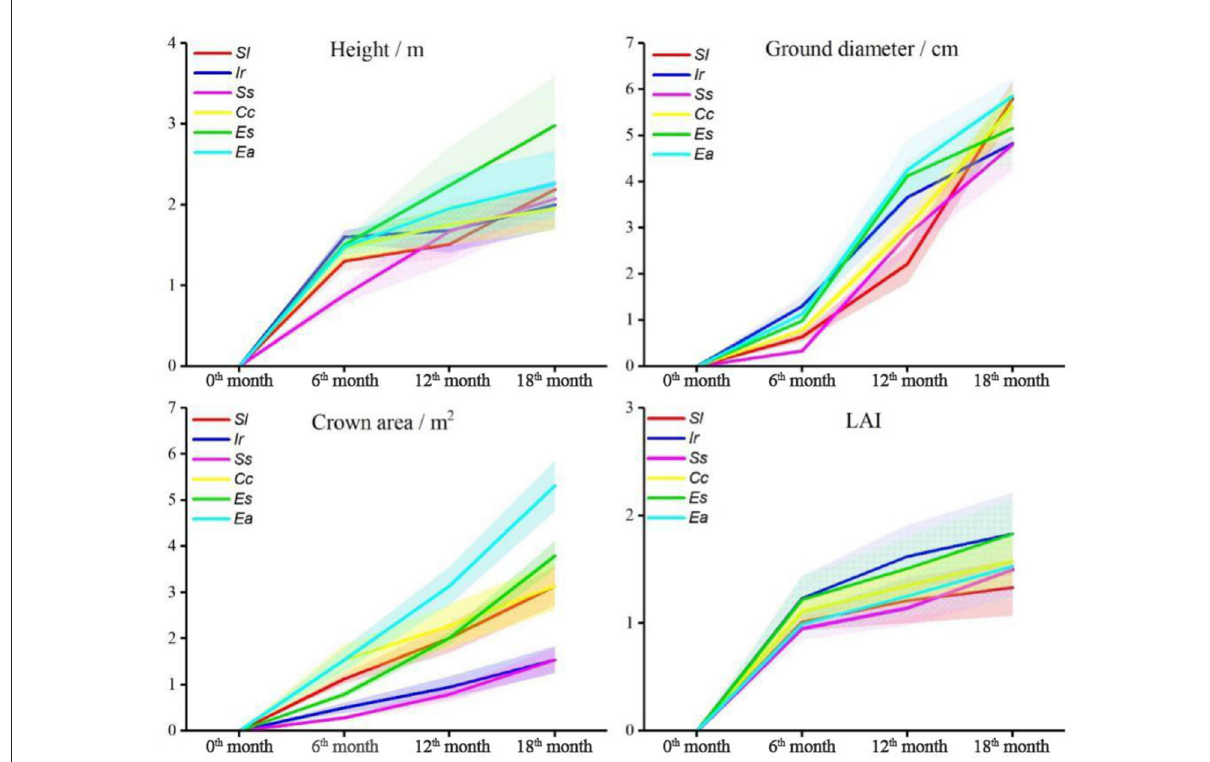
FIGURE3 Development of tree height (m), ground diameter (cm), crown area (m 2 ), and LAI of all the six tree species from the 0 to 18th month since plantation. The abbreviations of Sl , Ir , Ss , Cc , Es , and Ea were short for Sterculia lanceolata , Ilex rotunda , Schima superba , Cinnamomum camphora , Elaeocarpus sylvestris , and Elaeocarpus apiculatus . Around Sl (red line), Ir (cyan line), Ss (red-purple line), Cc (yellow line), Es (green line), and Ea (light blue line), the light shading areas are the 95% confidence intervals,